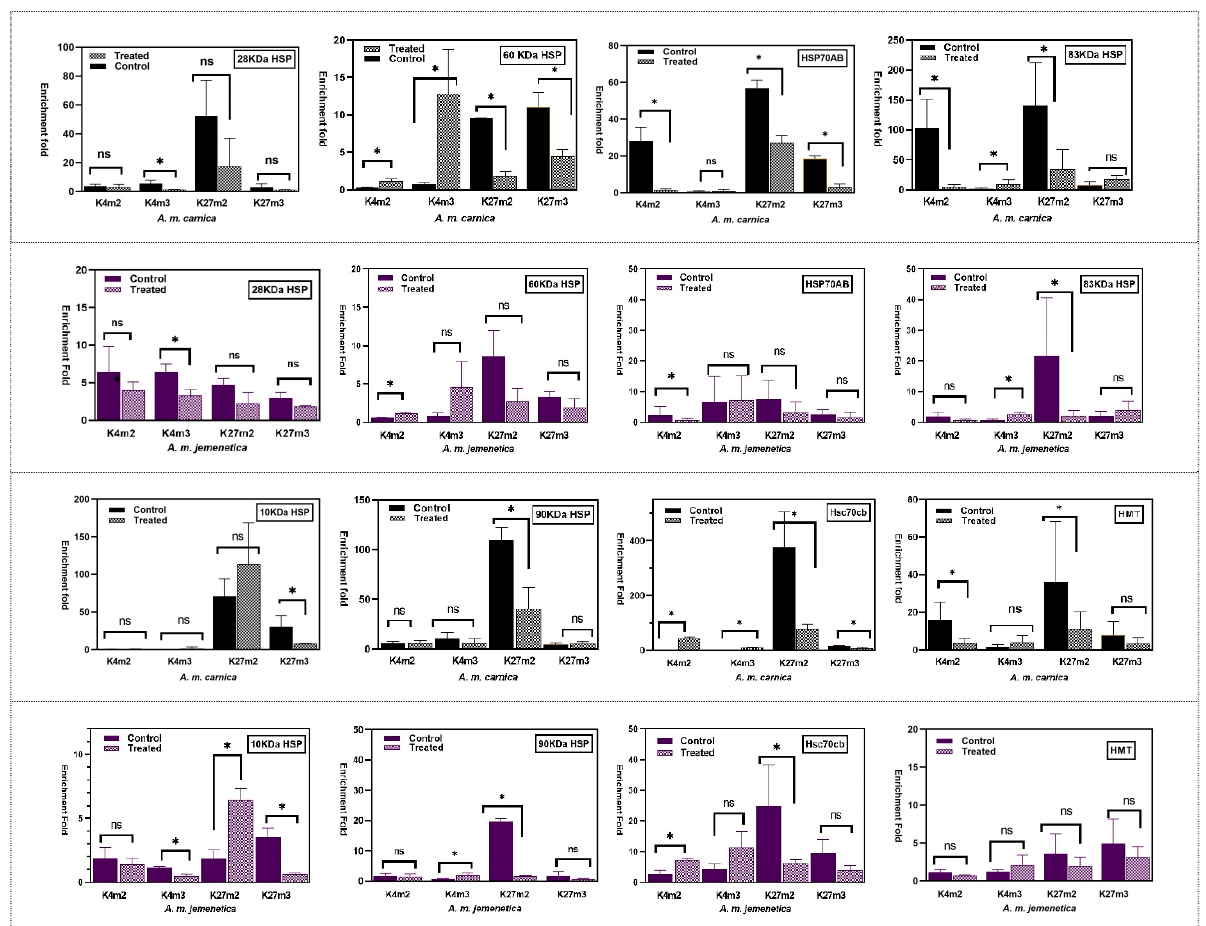
Figure 1. Comparison of the ChIP-qPCR enrichment folds of four histone marks at many heat shock protein genes, histone-lysine N-methyltransferase trithorax ( trx ), and heat shock cognate 70 cb (Hsc70cb) in thermo-tolerant A. m. jemenetica and thermo-susceptible A. m. carnica after exposure to heat stress (42 ◦ C for one hour). Active marks antibodies (H3K4me2 and H3K4me3) and repressive marks (H3K27me2 and H3K27me3) were used to pull down sonicated chromatin. DNA from non-immune IgG was used as a negative control to calculate the enrichment fold. Enrichment fold = 2 ct(IgG-AB) . (*) refers to significant differences between treatment and control, (ns) refers to non-significant differences (Table